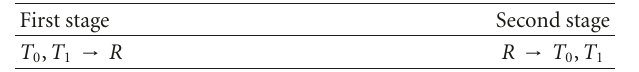
Table 1: Network